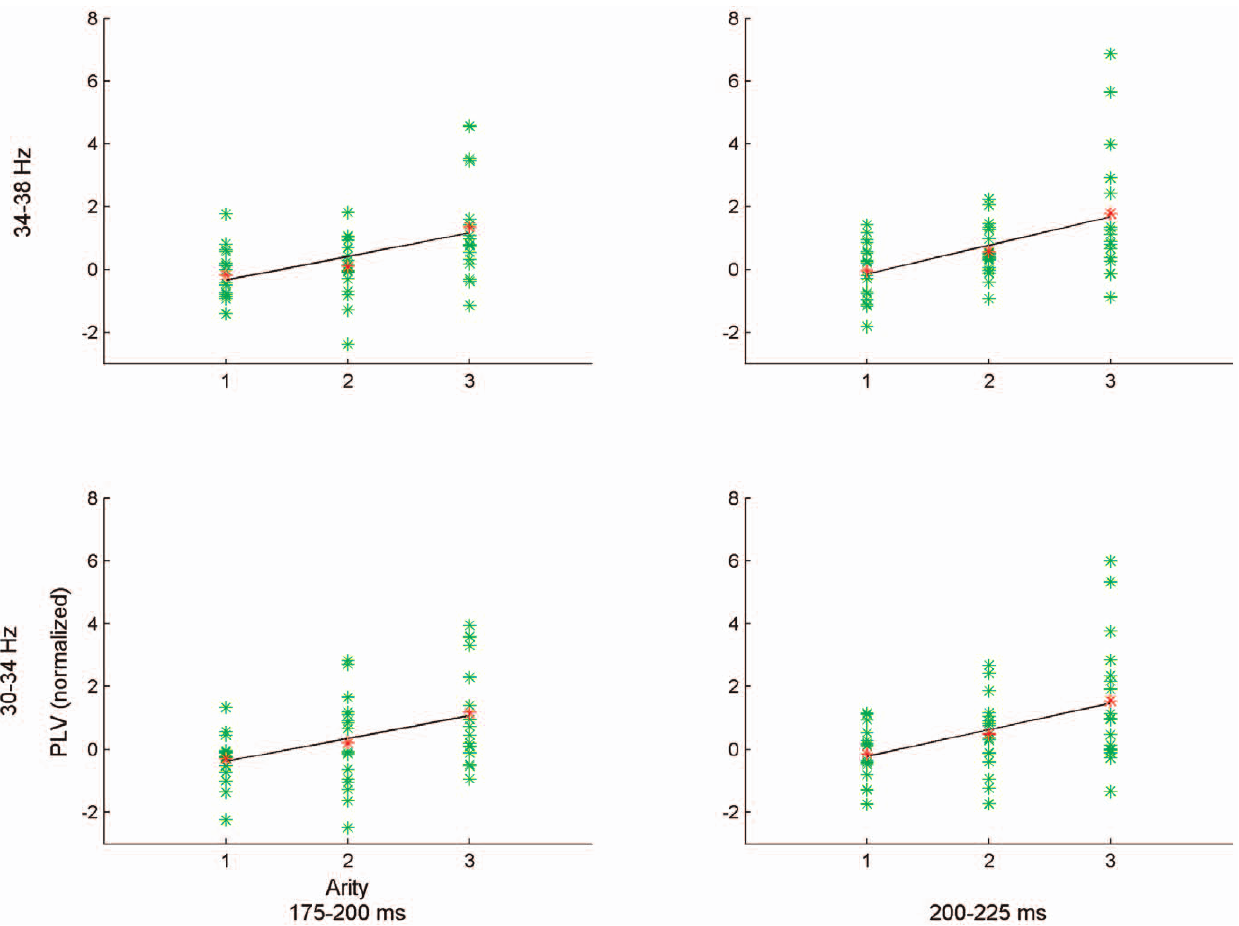
Figure 6. PLV-arity plots for reduced data set. Plot of PLV at each arity for each participant (green) and their mean (red) for significant frequency-time bands from the mean of F3-P3, Fz-Pz, and F4-P4 electrode pairs. Line indicates the regression slope.